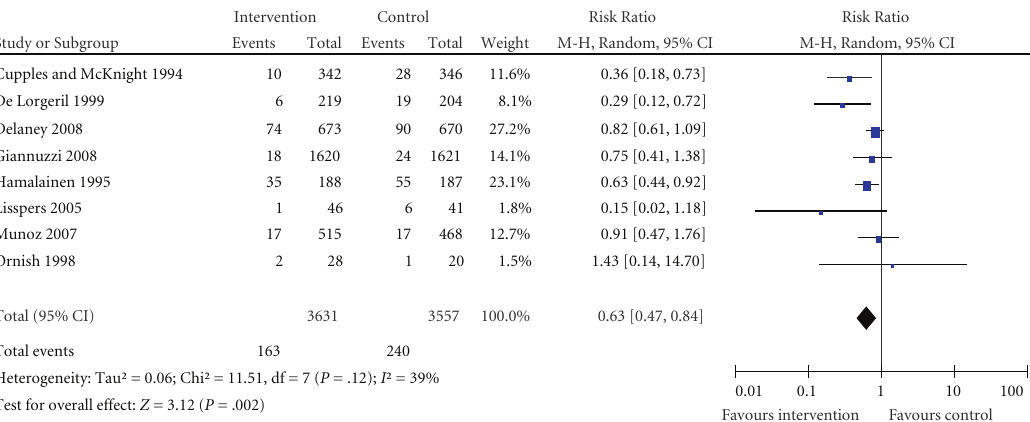
knowledge, and habits [21, 27, 44, 47], and for concern about dietary habits